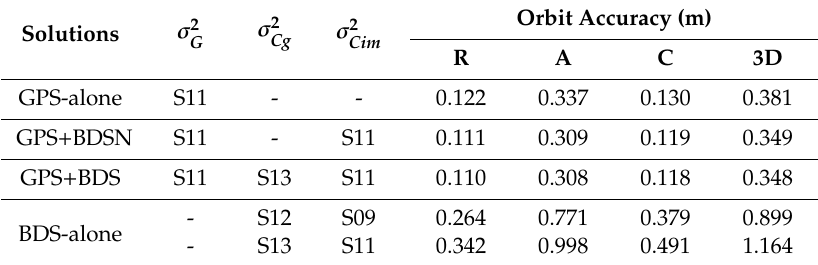
Table 4. The optimal values of σ 2 and the corresponding orbit